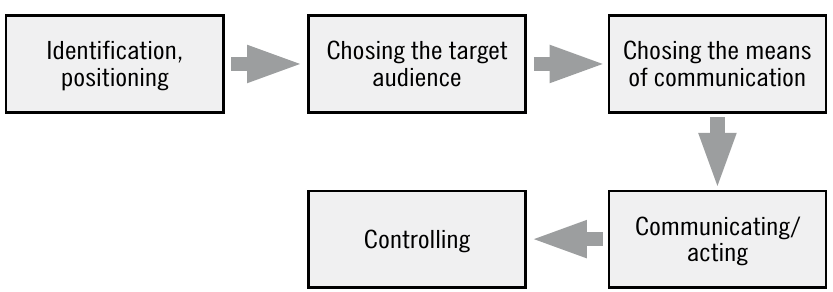
Source: own elaboration based on Wojtaszczyk and Maszewski (2014).